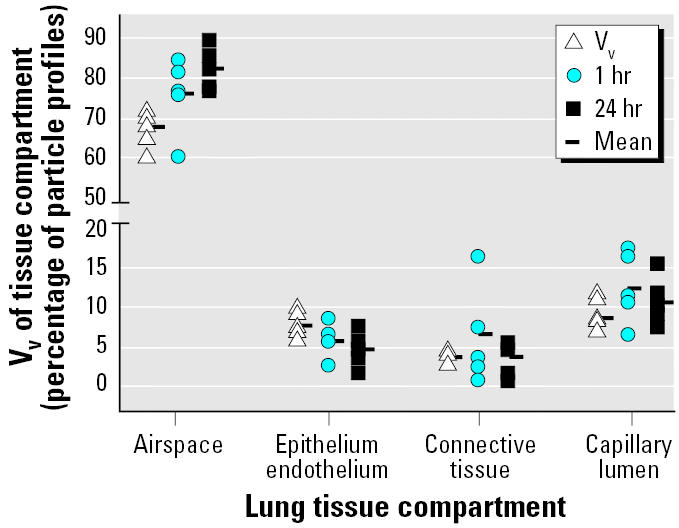
Relative distribution of particles localized in the different lung compartments at 1 hr and 24 hr after inhalation. Volume densities (Vv) for lung tissue compartments from Burri et al. (1973), Pinkerton et al. (1992), and Tschanz et al. (1995, 2003).